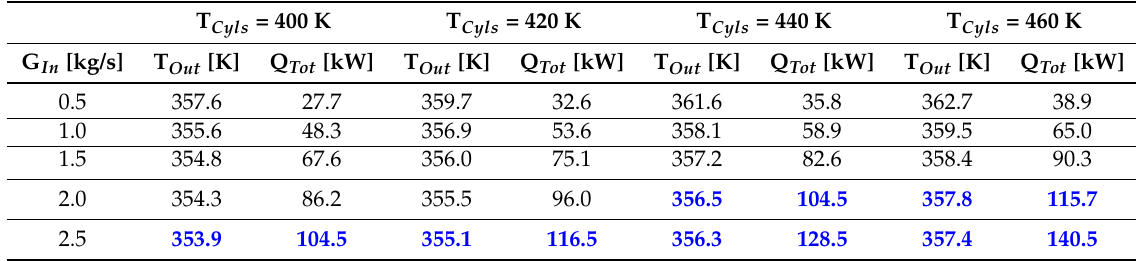
Table 4. Mass-averaged outflow temperature and total transferred heat flux tabulated as a function of G In and T Cyls for the double inlet